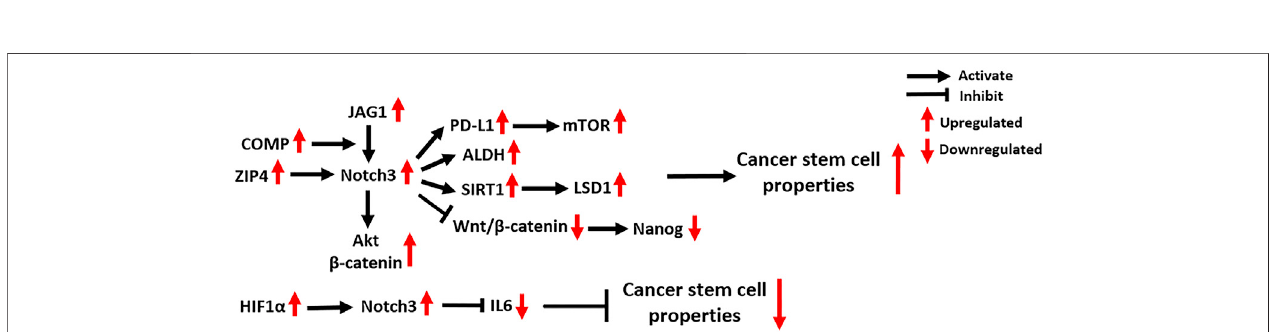
FIGURE3| AlterationsofNotch3geneinhumancancersfromTCGAweredeterminedusingthecBioCancerGenomicsPortal(http://cbioportal.org). (A) Typesof Notch3genealterationsfoundincancer. (B) Cancer-speci fi cNotch3genealterations. (C) Cancer-relatedmutationsofNotch3,including354missensemutations(green dots) and 55 truncation mutations (black dots).